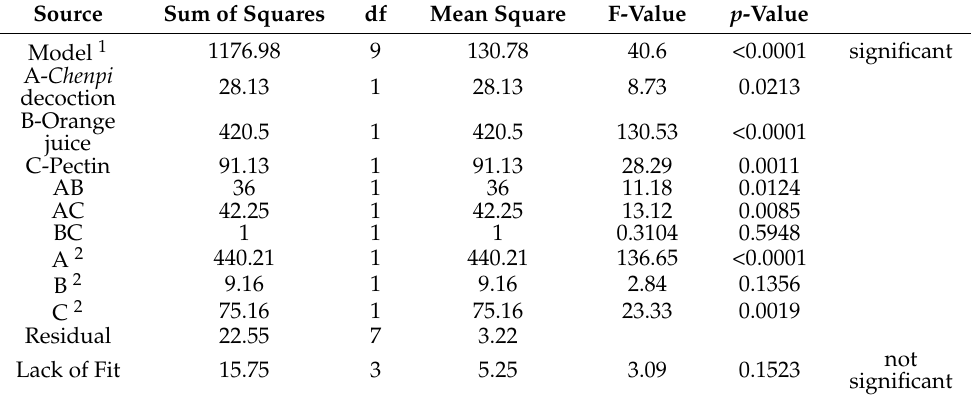
Table 5. Analysis of variance results for the CFJ 1